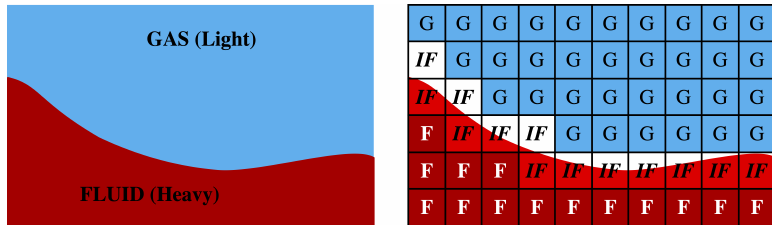
Figure 3. Three states treatment for free-surface model: fluid, interface, and